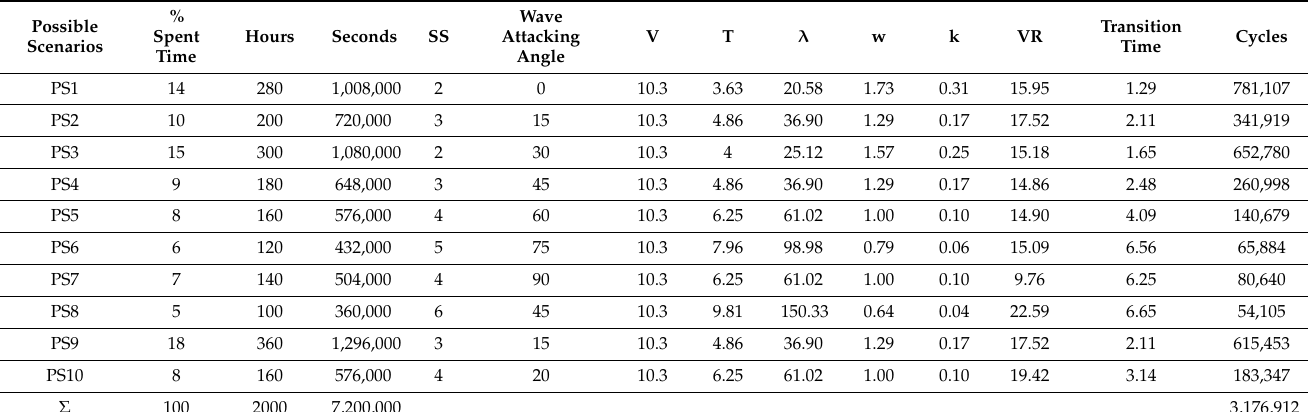
Table 13. Random sea condition loading